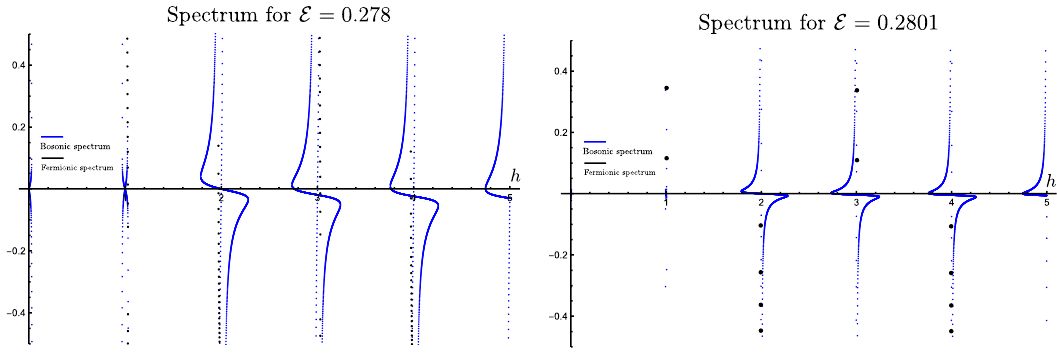
Figure 11 . Some bosonic correlators near transition, with E = 0 . 2780 , 0 . 2801 . Fermions do not flatten out, but the bosonic eigenvalues start to flatten. At E = E bosonic